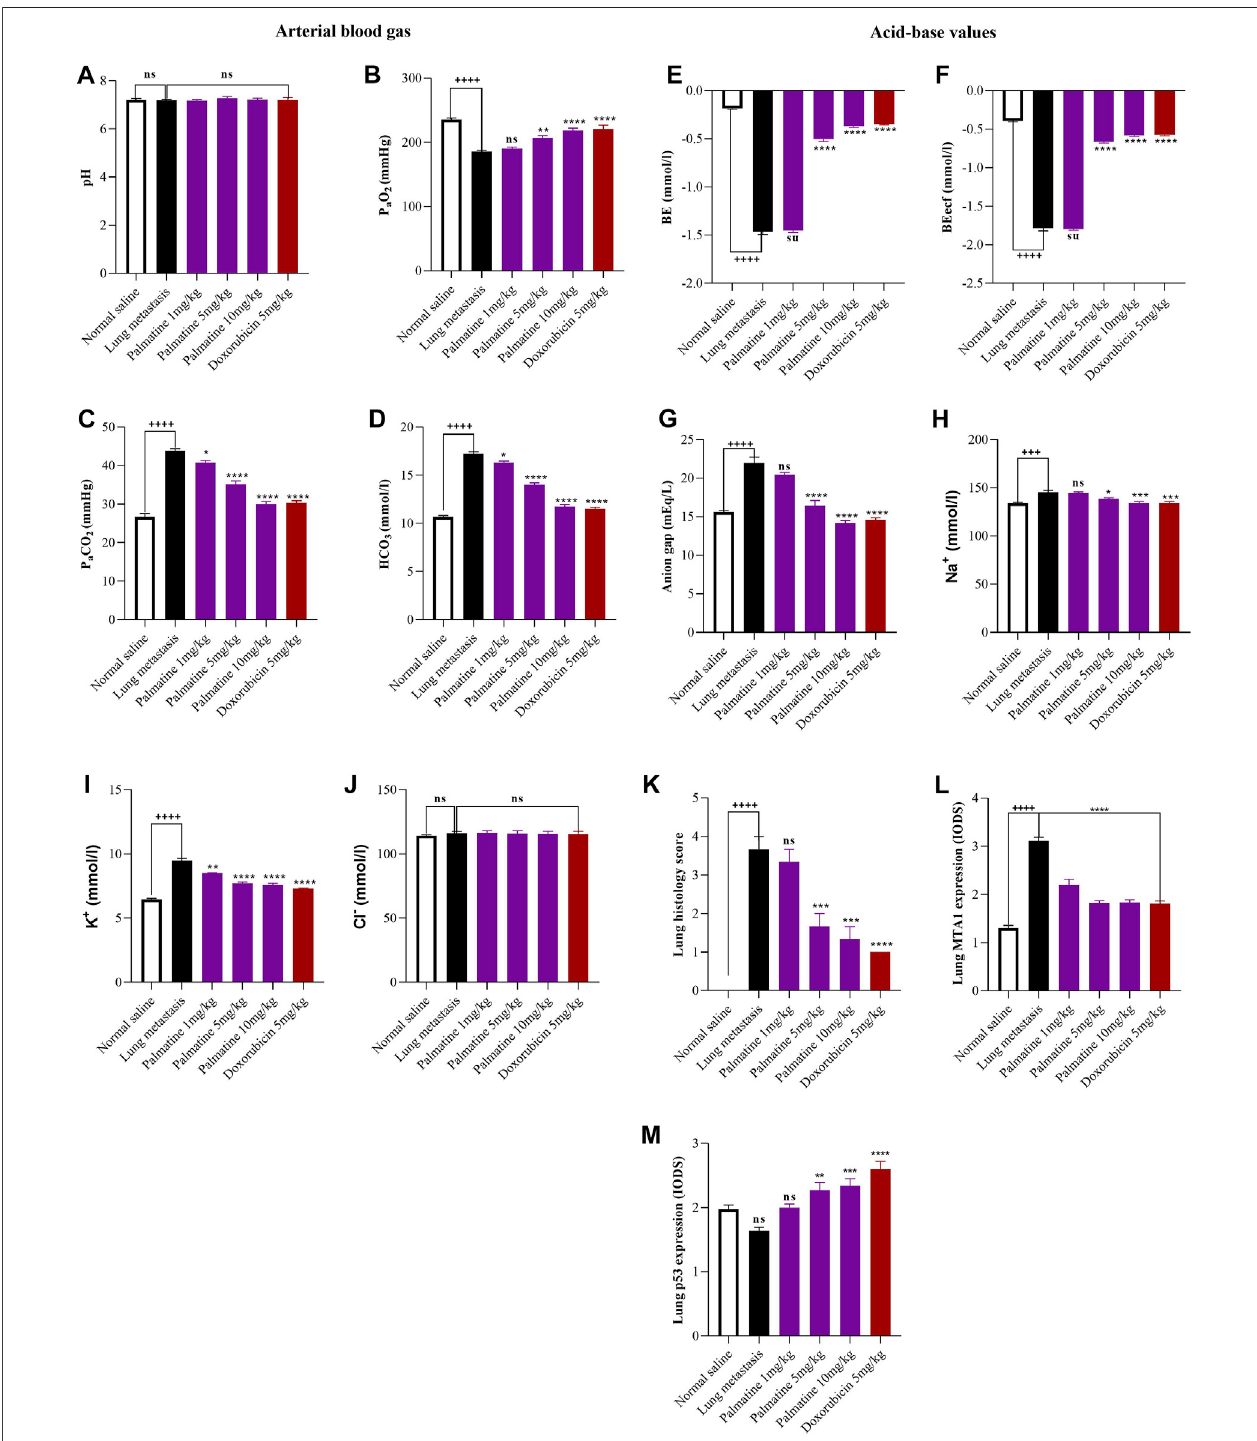
FIGURE 1 | Effect of palmatine on Lung metastasis. Data represents mean ± SEM. n = 10, One-way analysis of variance followed by Dunnett ’ s post hoc test. Lungarterial bloodgas: (A) potentialofhydrogen(pH), (B) partial oxygenpressure(PaO 2 ), (C) partialcarbondioxidepressure(PaCO 2 ), (D) bicarbonate(HCO 3 ). (A) ns (not signi fi cant) vs. Saline treated and Lung metastasis groups (B) ++++ p < 0.0001 vs. Saline treated group and ns (not signi fi cant), ** p = 0.002, **** p < 0.0001 vs. Lung metastasis group (C) ++++ p < 0.0001 vs. Saline treated group and * p = 0.025, **** p < 0.0001 vs. Lung metastasis group (D) ++++ p < 0.0001 vs. Saline treated group and * p = 0.0127, **** p < 0.0001 vs. Lung metastasis group. Lung acid-base values: (E) base excess (BE) (F) base excess extracellular fl uid (BE ecf) (G) anion gap (H) sodium (Na + ) (I) potassium (K + ) (J) Chloride (Cl − ). (E – G) ++++ p < 0.0001 vs. Saline treated group and ns (not signi fi cant), **** p < 0.0001 vs. Lung metastasis group (H) +++ p = 0.0002 vs. Saline treated group and ns (not signi fi cant), * p = 0.0112, **** p < 0.0002 vs. Lung metastasis group (I) ++++ p < 0.0001 vs. Saline treated group and ** p = 0.0016, **** p < 0.0001 vs. Lung metastasis group (J) ns (not signi fi cant) vs. Saline treated and Lung metastasis group.